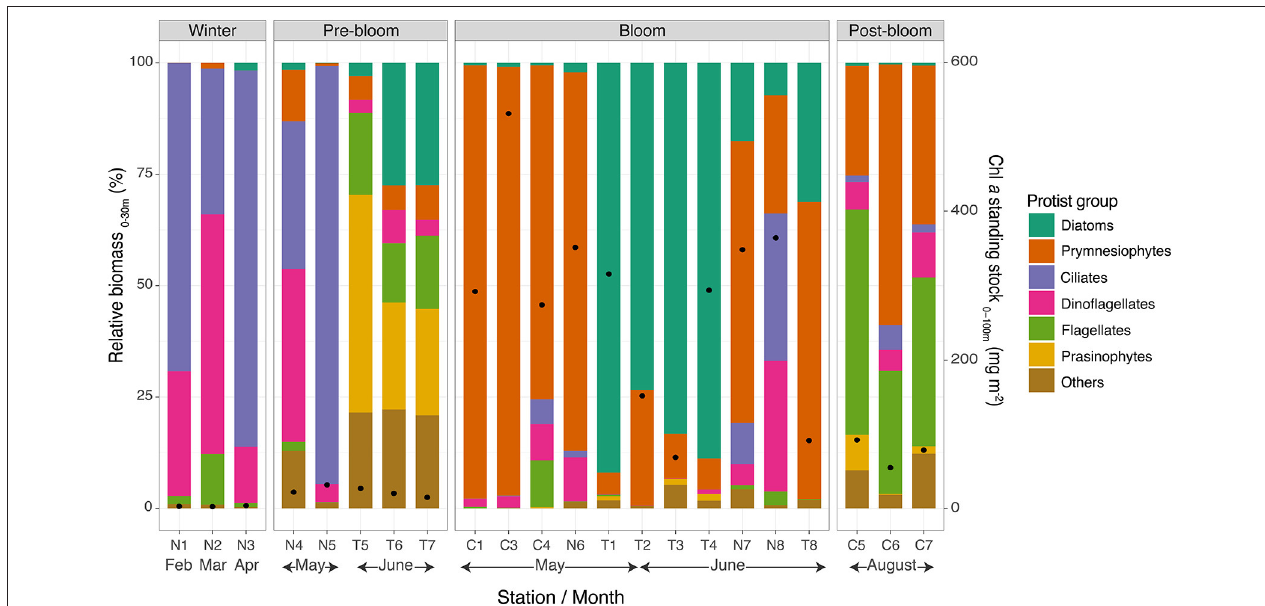
FIGURE 6 | Relative biomass of dominant protist groups in the upper 30m of the water column (bars) and Chl a standing stocks in the upper 100m. Note that “C” stations were sampled in 2014 and “N” and “T” stations in 2015.